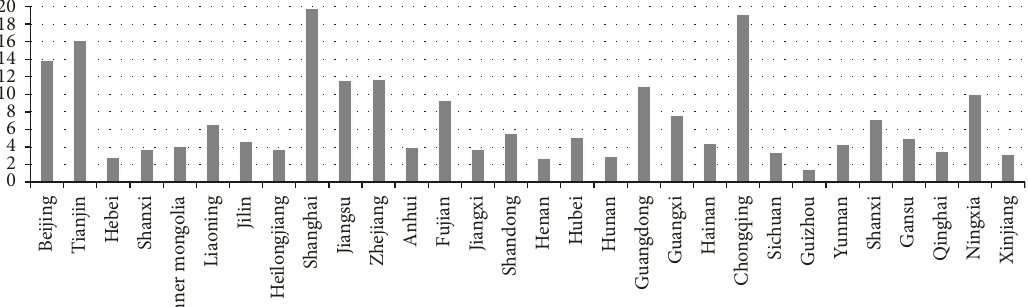
Figure 4: The average value of voluntary environmental regulation